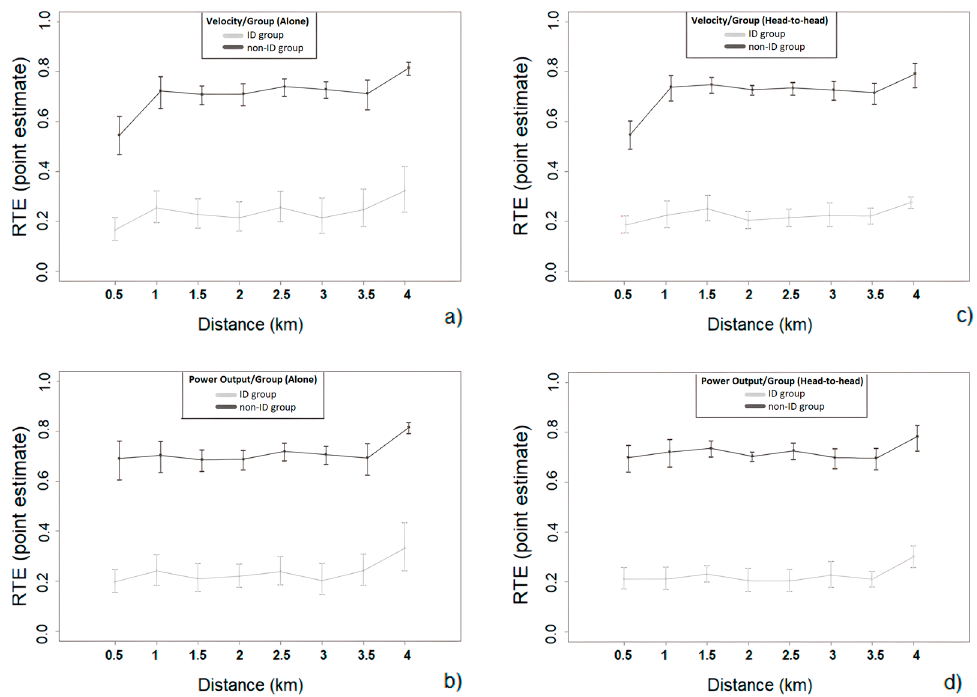
Figure 2. Relative effects and 95% confidence intervals for the velocity and power output of the ID and non-ID group during the ‘alone’ ( a , b ) and ‘head-to-head’ condition ( c , d ).